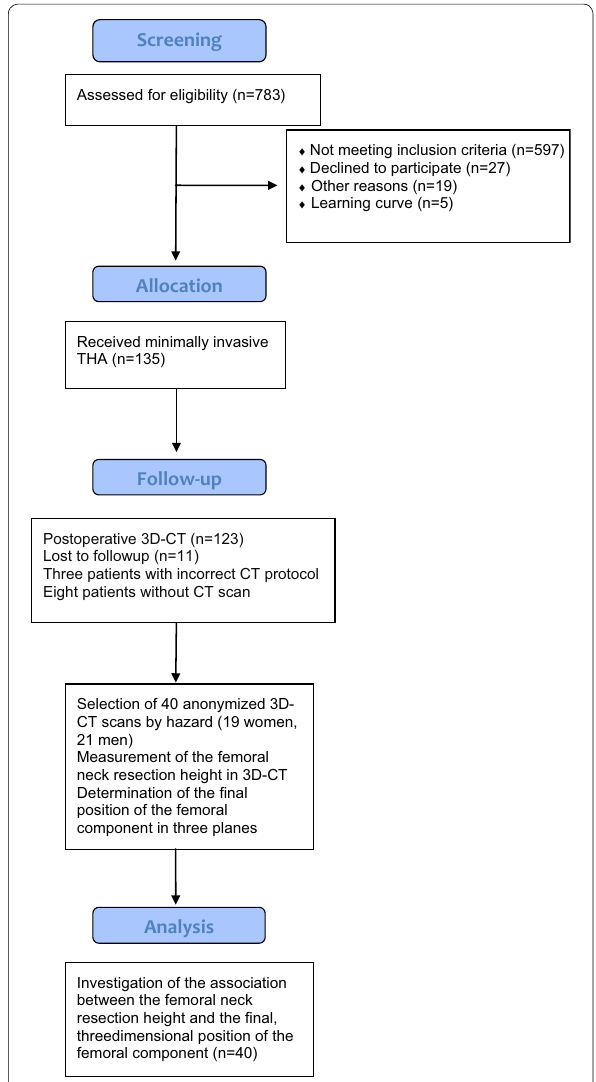
Fig. 1 Consolidated Standards for Reporting Trials flow diagram for participants. ( THA total hip arthroplasty)